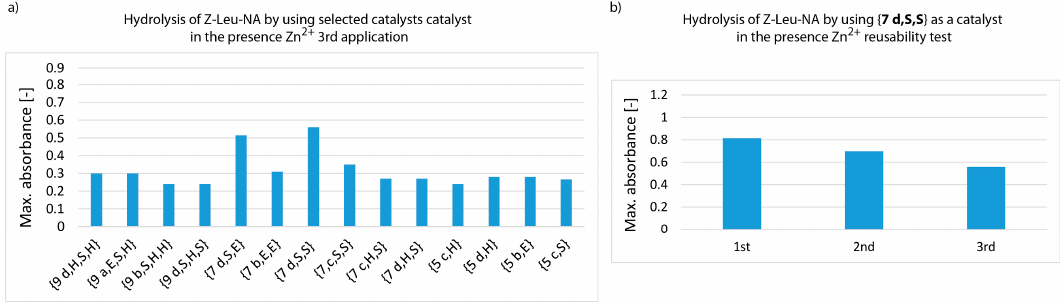
Figure 9. Measurement of Z-Leu-NA hydrolysis at pH 8.5 using the most effective synzymes with Zn 2+ docked in the active pocket (third catalytic cycle, left panel a ). Hydrolytic efficiency of 7 d,S,S in the presence of Zn 2+ ions after three subsequent re-use (right panel b ).